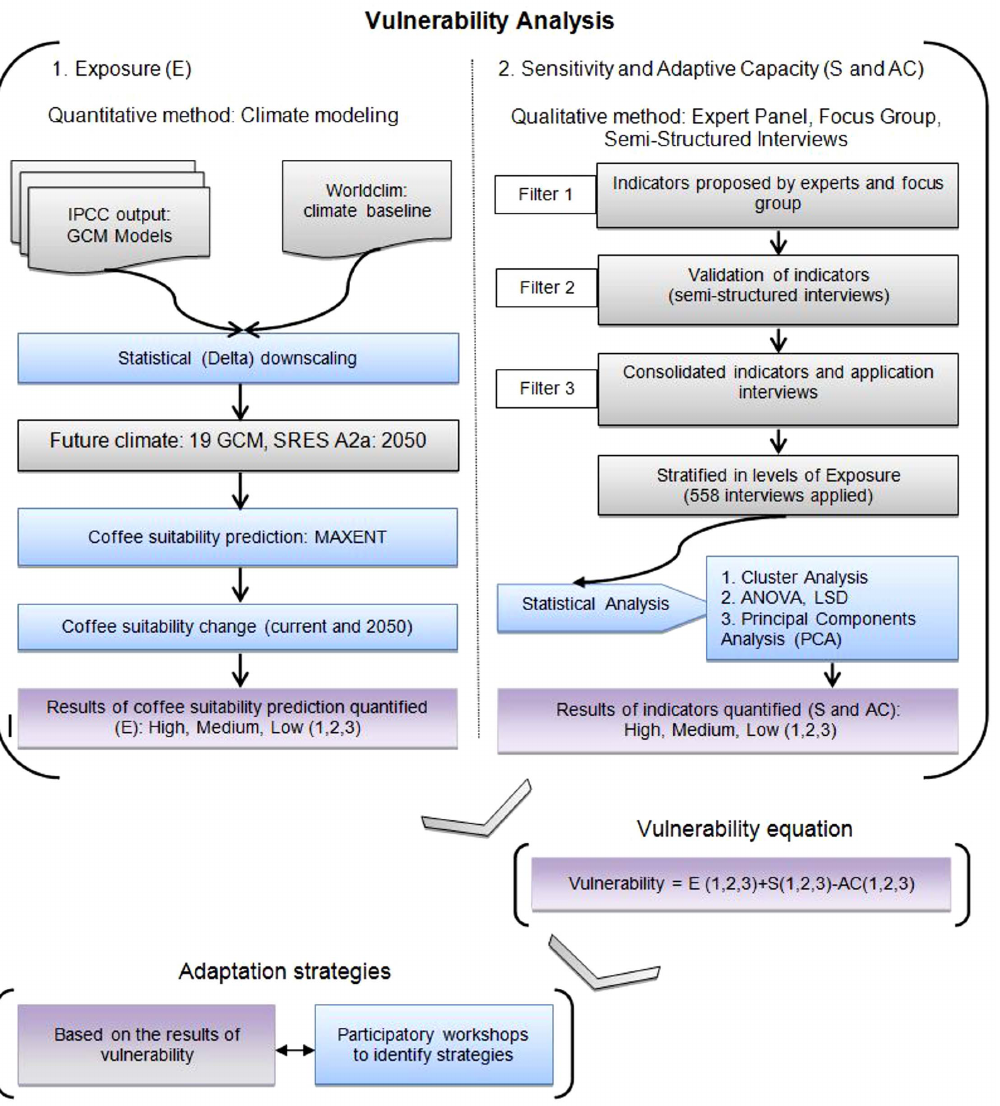
Figure 1. Framework to assess the vulnerability of coffee communities and to identify strategies for adaptation to climate change.